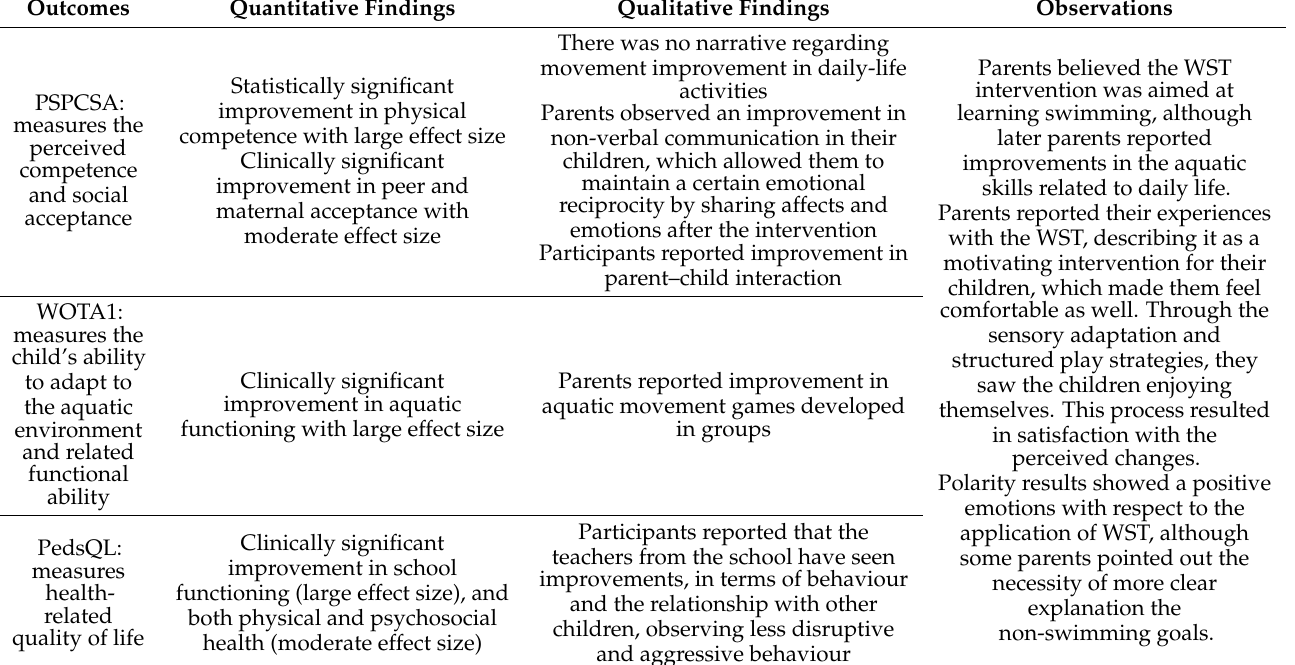
Table 3. Combined display of the quantitative and qualitative